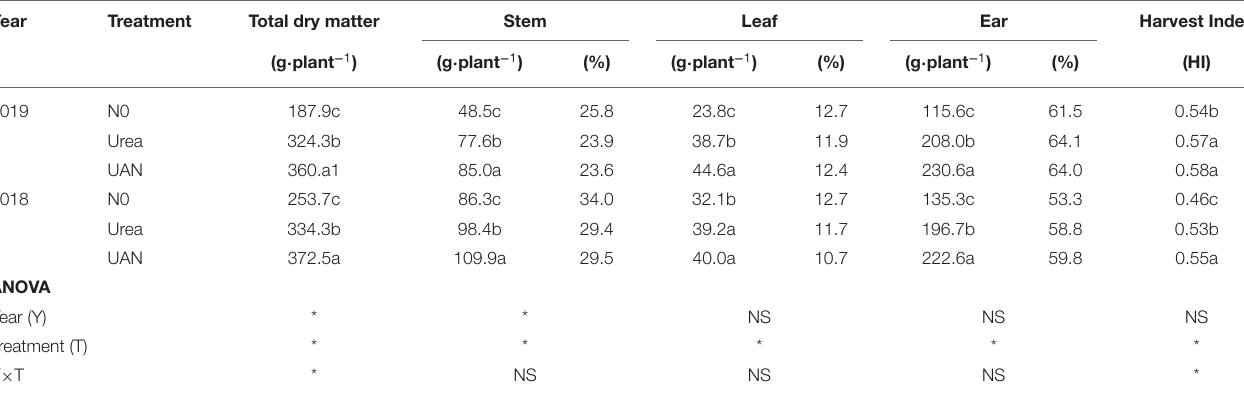
TABLE 2 | Effects of nitrogen fertilizer types on dry matter accumulation and distribution of summer